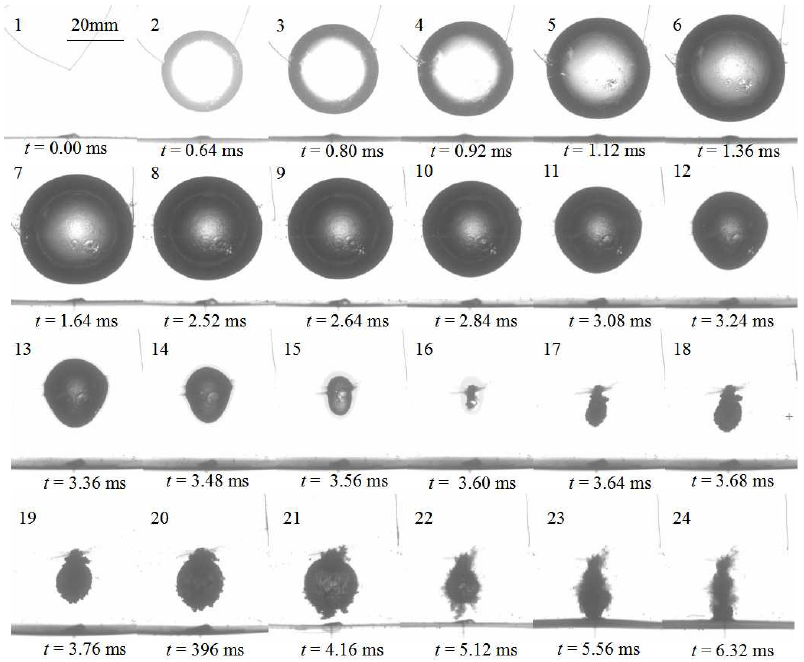
Figure 7. Temporal evolution of bubble shapes for γ = 1.20 and R m = 20.0 mm.